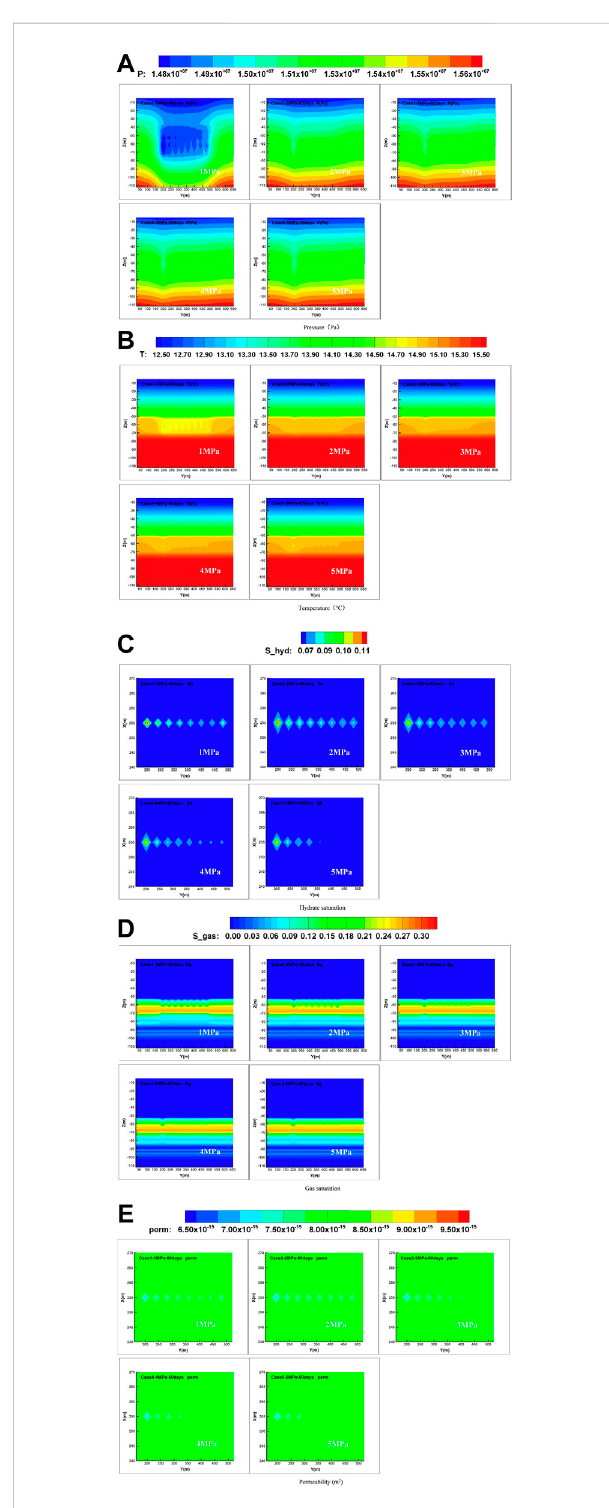
FIGURE 11 Spatial distribution of pressure (A) , temperature (B) , hydrate saturation (C) , gas saturation (D) , and permeability (E) after 60 days of depressurization production with different production